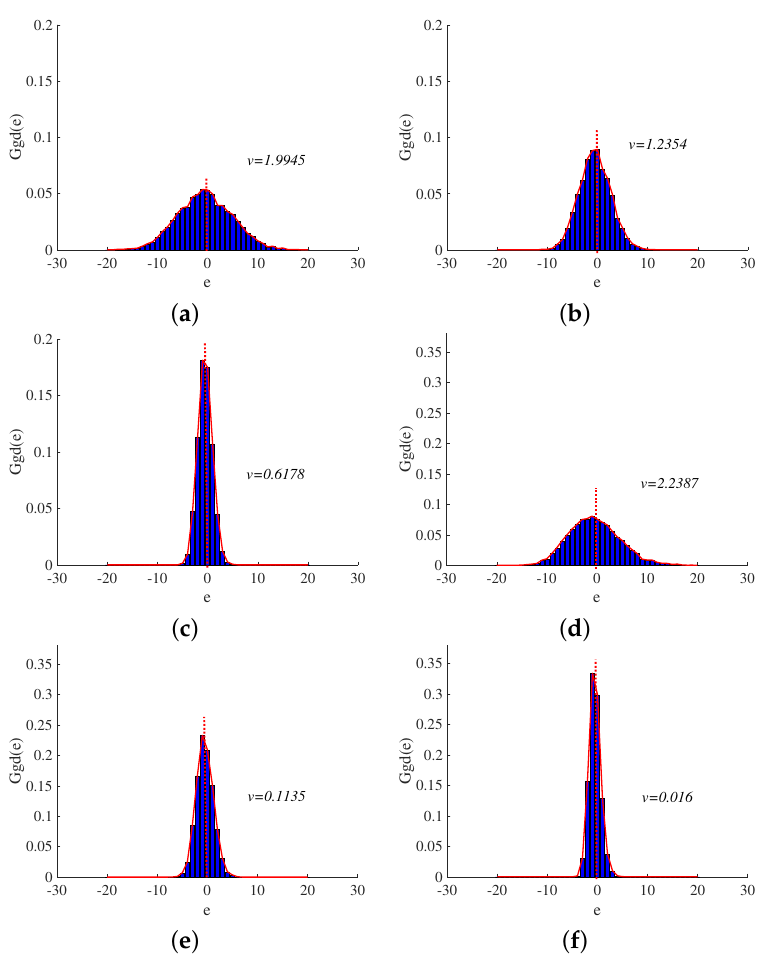
Figure 4. The probability density histograms of errors e ( t ) of the plane imaging in ( a ) t = 1, ( b ) t = 2 and ( c ) t = 3 iterations and the ship imaging in ( d ) t = 1, ( e ) t = 2 and ( f ) t = 3 iterations. The shape parameter ρ in generalized Gaussian probability density function keeps constant of 1.3 for these instances. The horizontal axis denotes the range of pixel values in e and the vertical axis denotes the probability Ggd ( e ) of the number of pixel values in different ranges to the number of total